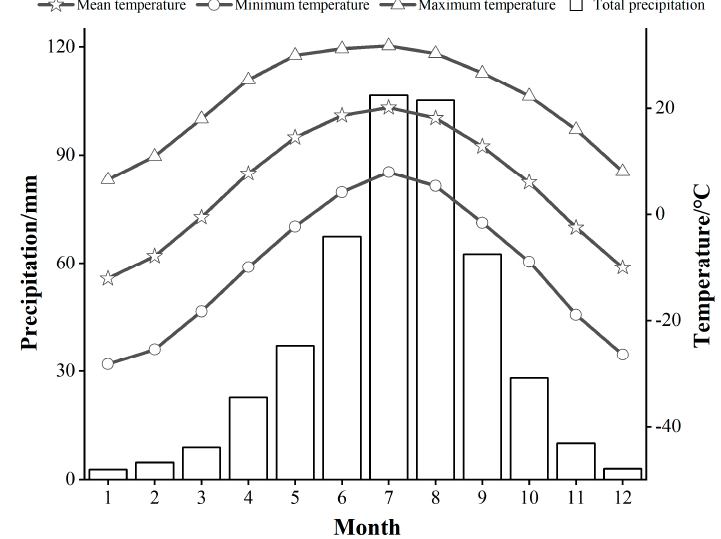
Figure 1. Monthly total precipitation, mean temperature, and maximum and minimum temperature during 1970–2020 using the records from the four meteorological stations, north-central China.